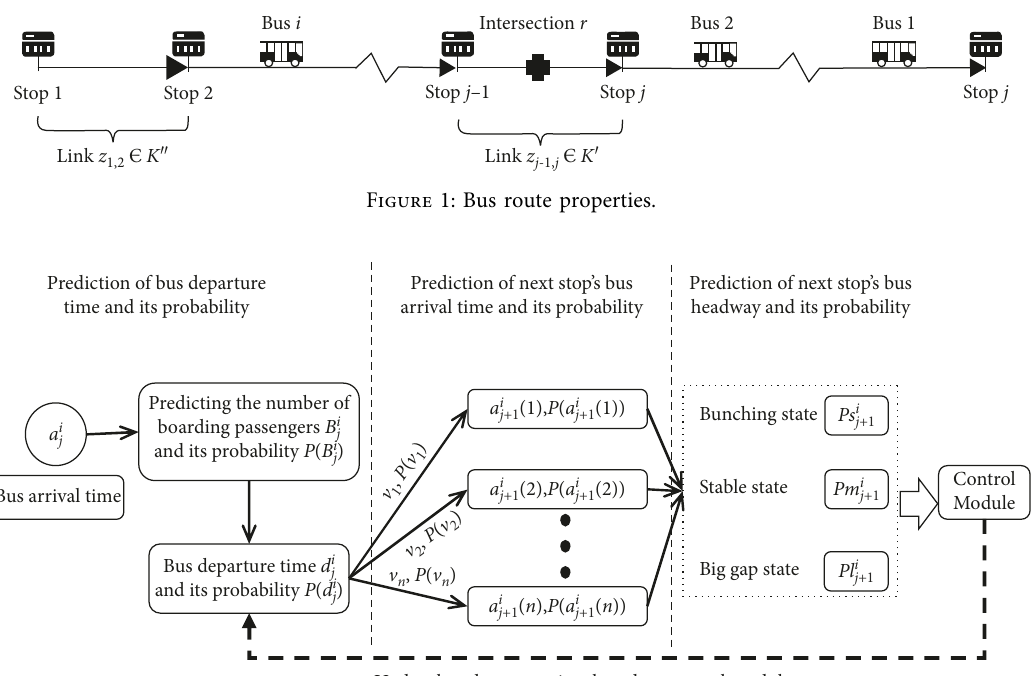
Figure 2: Principle of the headway probability prediction